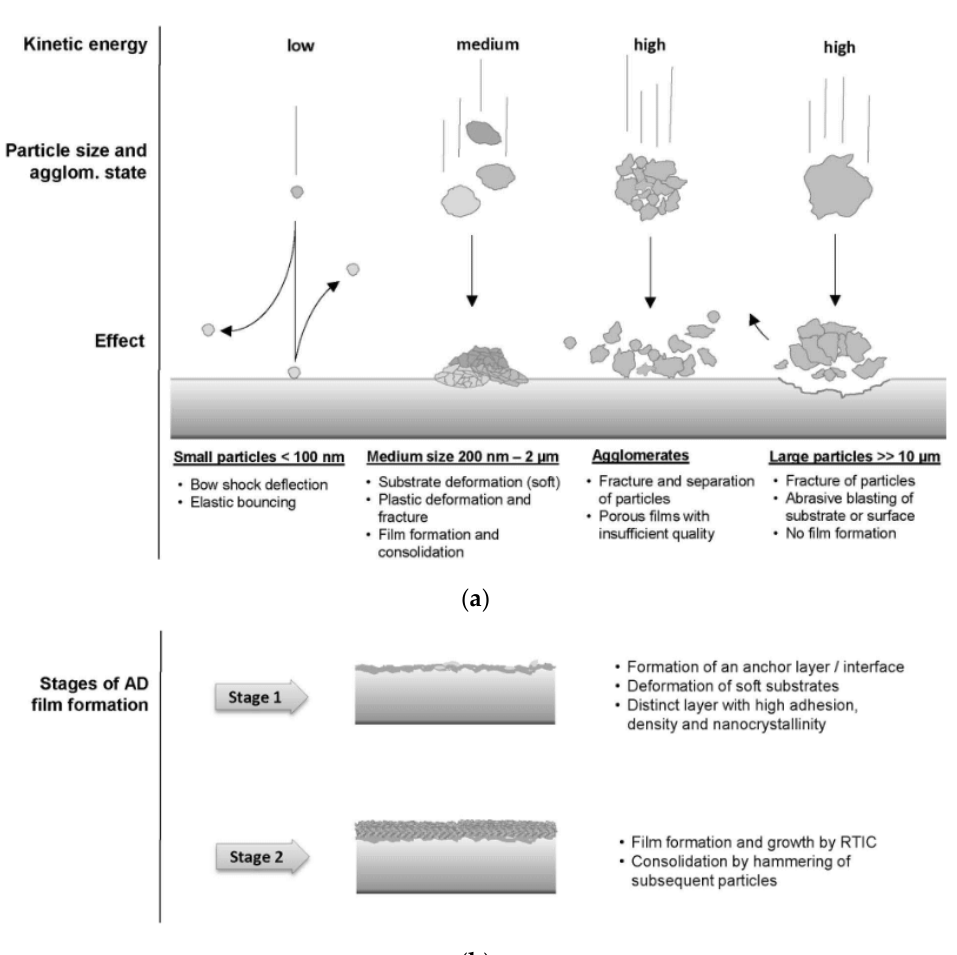
Figure 21. Possible particle-substrate interactions based on the speed and kinetic energy of the ceramic particles ( a ) and the room temperature impact consolidation process, with a distinction between stage 1 (anchor layer formation) and stage 2 (film buildup), during which particle hammering and fracturing takes place ( b ) [73].